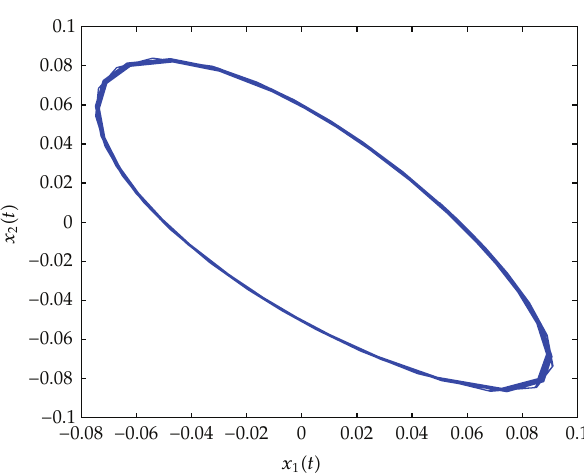
Figure 6: Trajectories graphs of the system (cid:2) 4.1 (cid:3) with τ 1 (cid:6) 0 . 01 ,τ 2 (cid:6) 0 . 04, and τ 1 (cid:7) τ 2 (cid:6) 0 . 05 > τ 0 ≈ 0 . 01. Hopf bifurcation occurs from the equilibrium E ∗ (cid:2) 0 , 0 (cid:3) . The initial value is (cid:2) 0.05, 0.01 (cid:3)